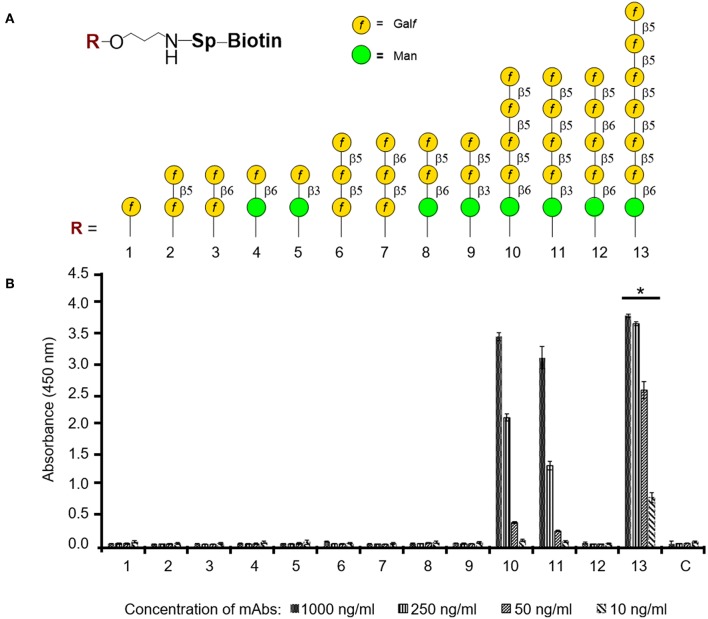
ELISA to determine the oligosaccharide specificity of mAb AP3. (A) Composition of thematic glycoarray oligosaccharide ligands representing key structural elements of GM. The carbohydrate sequences are represented as previously reported (Varki et al., 2009). (B) Carbohydrate specificity of antibody AP3. Biotin-tagged oligosaccharides 1–13 were applied to a streptavidin-coated microtiter plate and detected with mAb AP3 (1,000, 250, 50, and 10 ng/ml) and anti-mouse IgG HRP conjugate followed by TMB substrate incubation. All measurements were taken twice in triplicate. Asterisk denotes the statistically significant difference in binding between AP3 and heptamer 13 compared to pentamers 10 and 11 (p < 0.05).